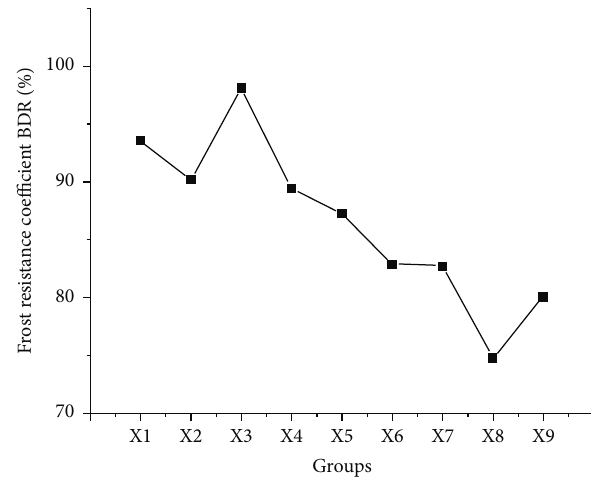
Figure 20: Frost resistance coefficient